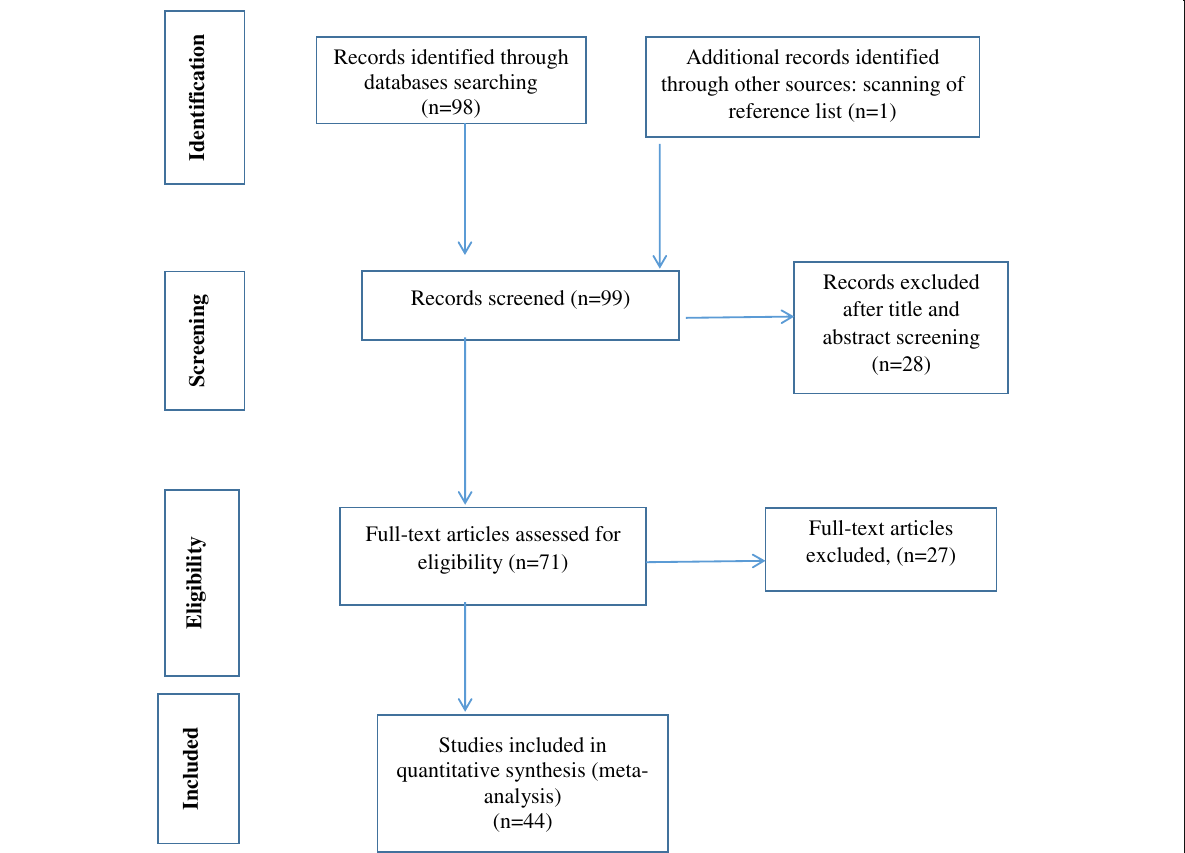
Fig. 1 The process of surveying, screening, and selecting the articles for systematic review and meta-analysis based on PRISMA guideline. Ninety- nine studies were identified in the initial search (identification). After the title and abstract screening, 28 studies were excluded (screening). Based on the inclusion and exclusion criteria, 27 studies were excluded from the final analysis (Eligibility). A total of 44 articles were included in